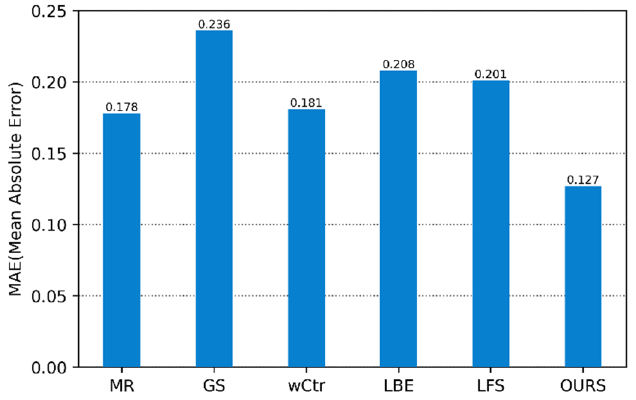
Figure 5. MAE of our proposed method and other salient object detections in the light field da ‐